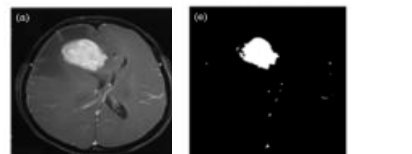
Table 2. The following